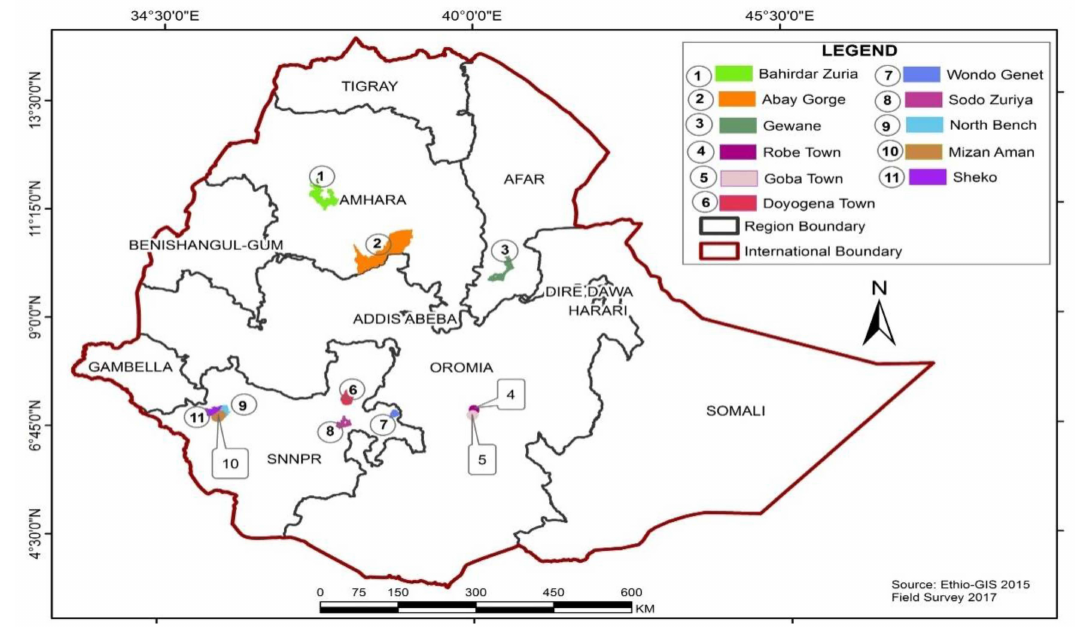
Figure 2. Map of Ethiopia showing the location of study districts.